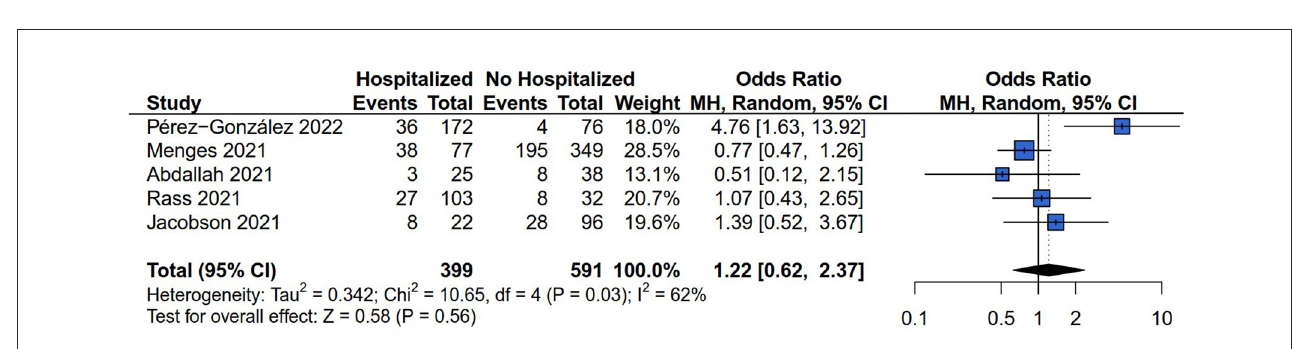
FIGURE3 Forest plot for meta-analysis of general symptom risk among Hospitalized vs. non-hospitalized COVID-19 survivors.